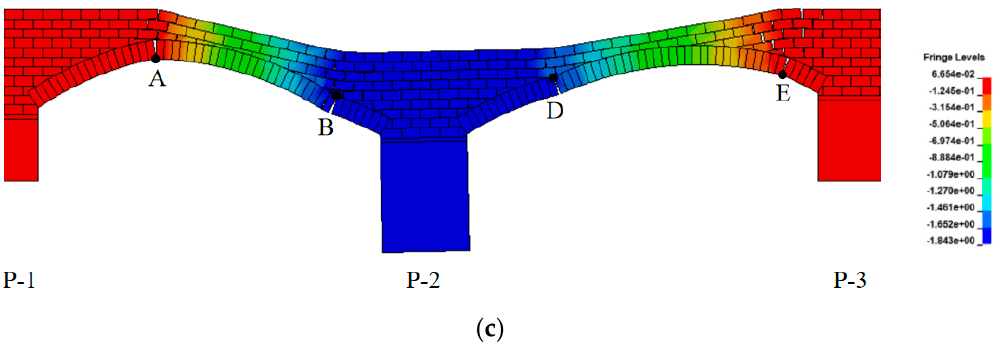
Figure 12. Cracks and hinges of the bridge (in the contour of vertical displacement, unit: m): ( a ) δ 1 = 0.90 m, δ 2 = 0.86 m; ( b ) δ 1 = 1.40 m, δ 2 = 1.33 m; ( c ) δ 1 = 1.80 m, δ 2 = 1.71 m.